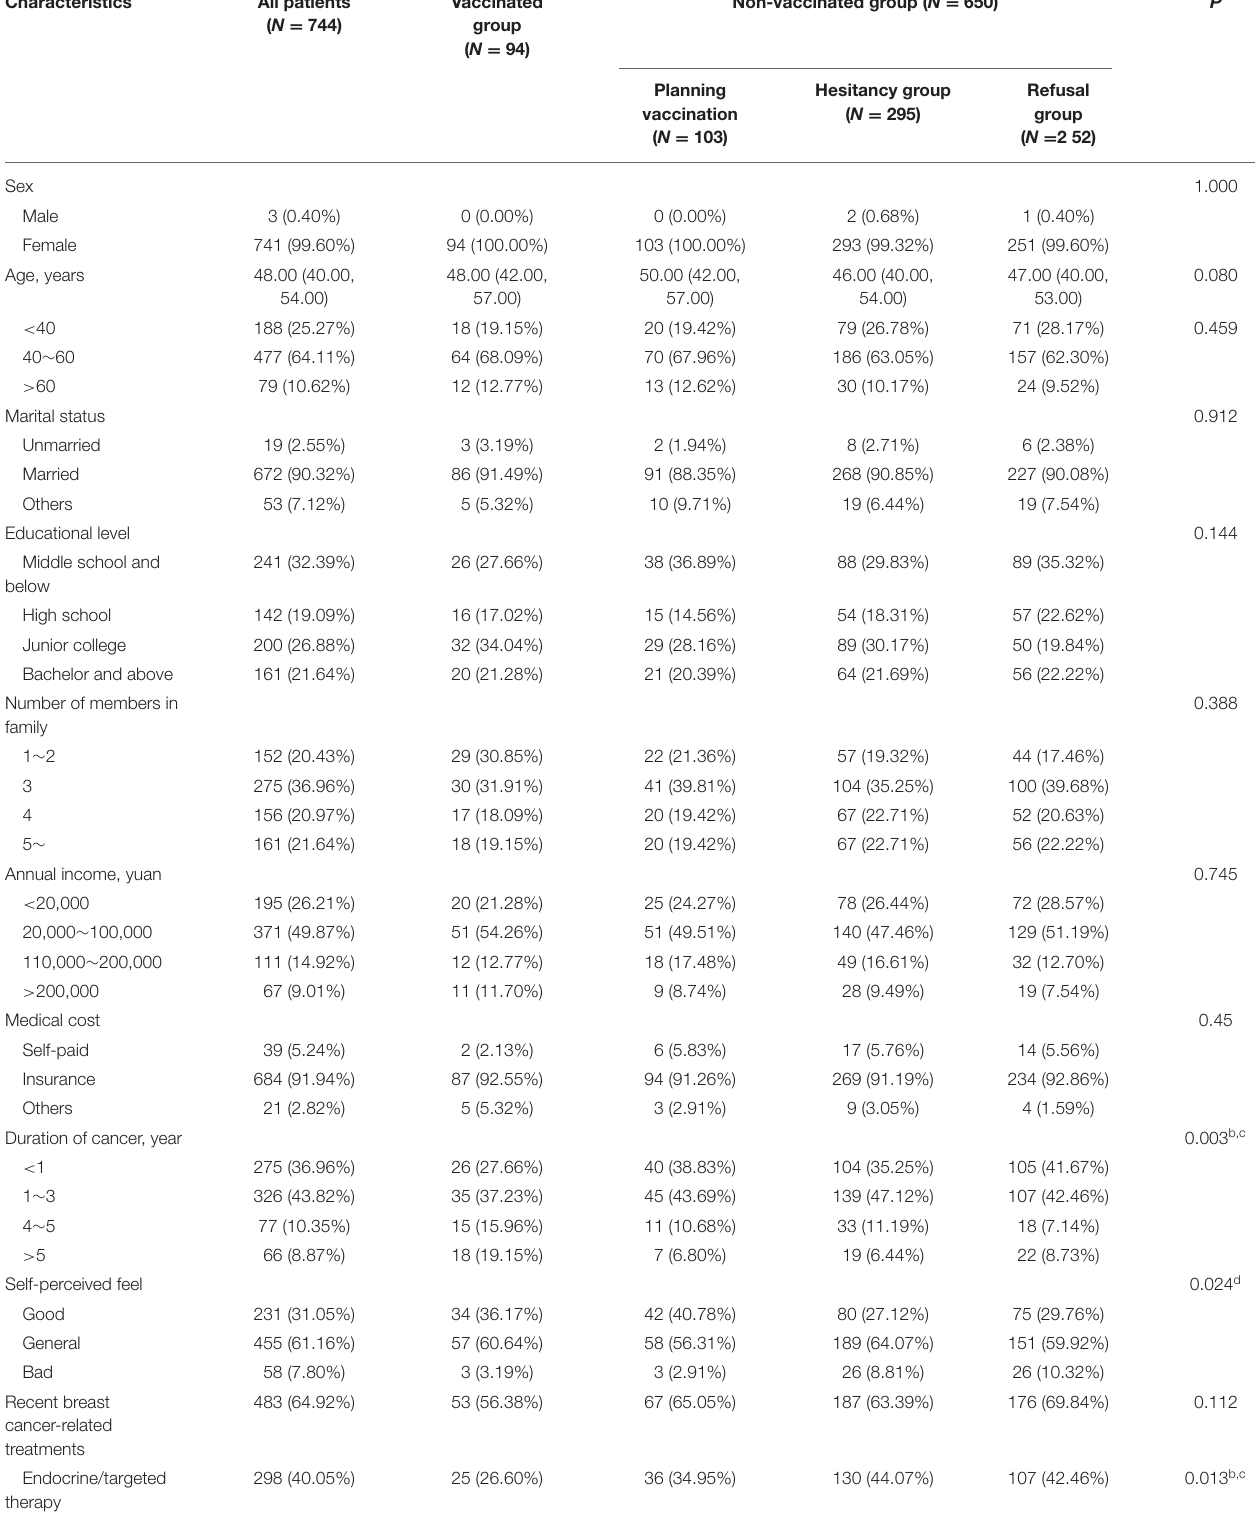
TABLE 1 | Basic characteristics of breast cancer